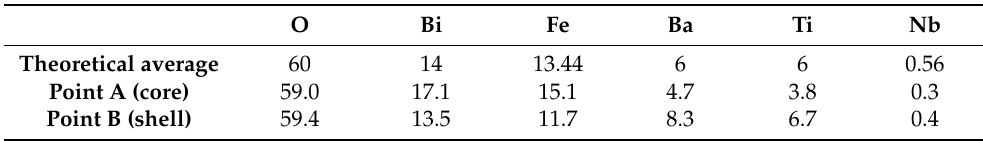
Table 2. EDS point analysis (atomic %) of selected core (A) and shell (B) regions of the 0.7BF–0.3BT– 4Nb ceramic shown in Figure 3.